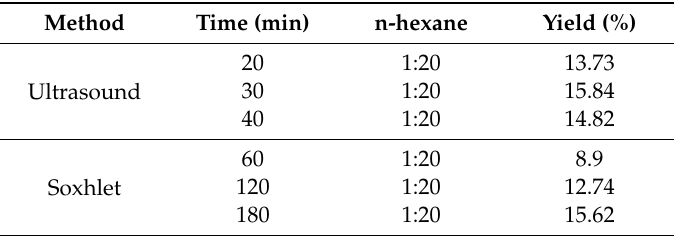
Table 3. Comparison of WCG oil yield of Soxhlet and ultrasonic-assisted extraction